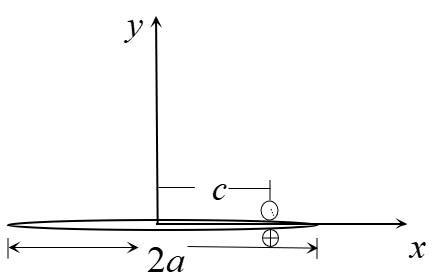
Figure 1. Griffith crack in cubic quasicrystal piezoelectric materials.